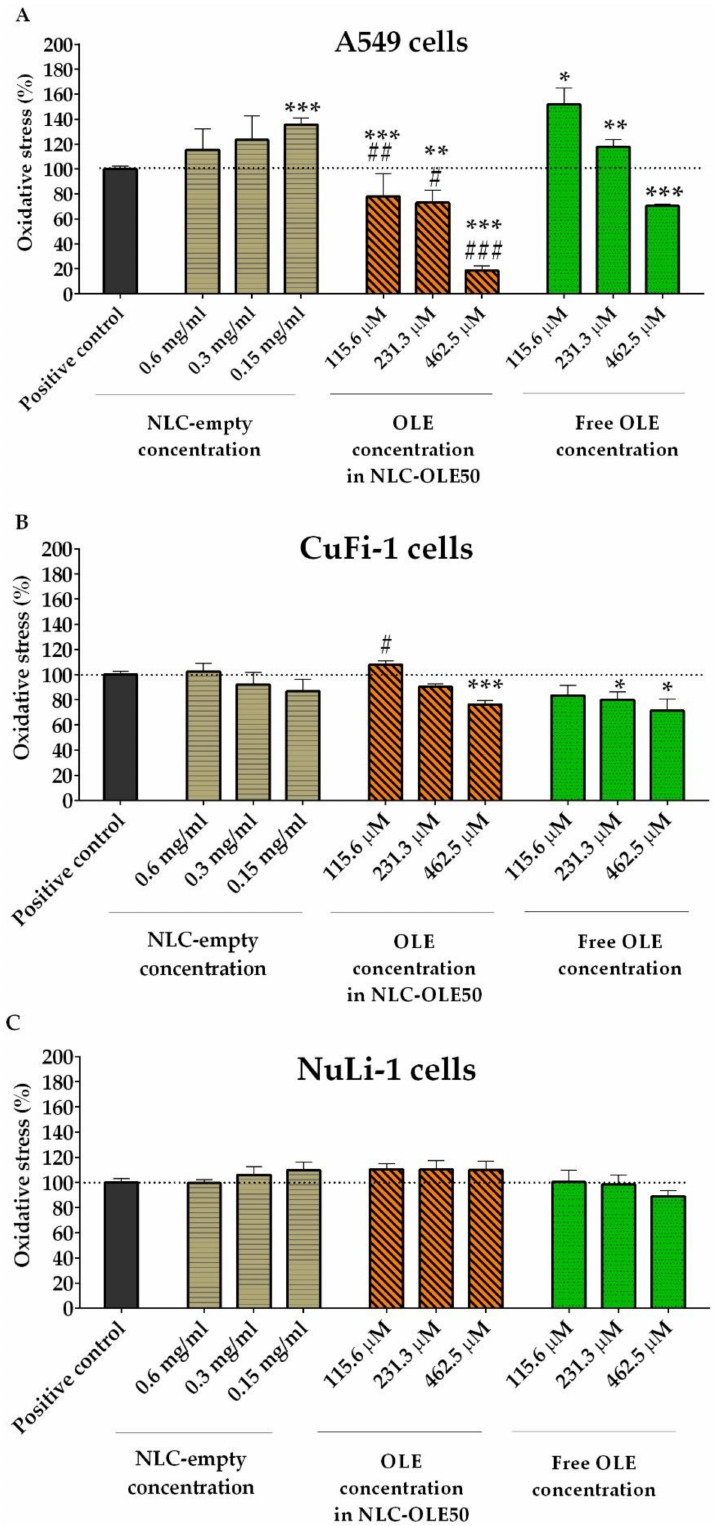
Figure 5. Antioxidant activity of free oleuropein (OLE), encapsulated OLE (NLC-OLE50), and empty nanoparticles (NLC-empty) in ABAP-stressed A549 ( A ), CuFi-1 ( B ), and NuLi-1 ( C ) cells. The mean percentages of DCF fluorescence, as a measure of oxidative stress, are shown in relation to the positive control (set to 100%). Results shown are means ± SEM of at least three independent experiments. * p < 0.05, ** p < 0.01, *** p < 0.001 vs. positive control; # p < 0.05, ## p < 0.01, ### p < 0.001 vs. free